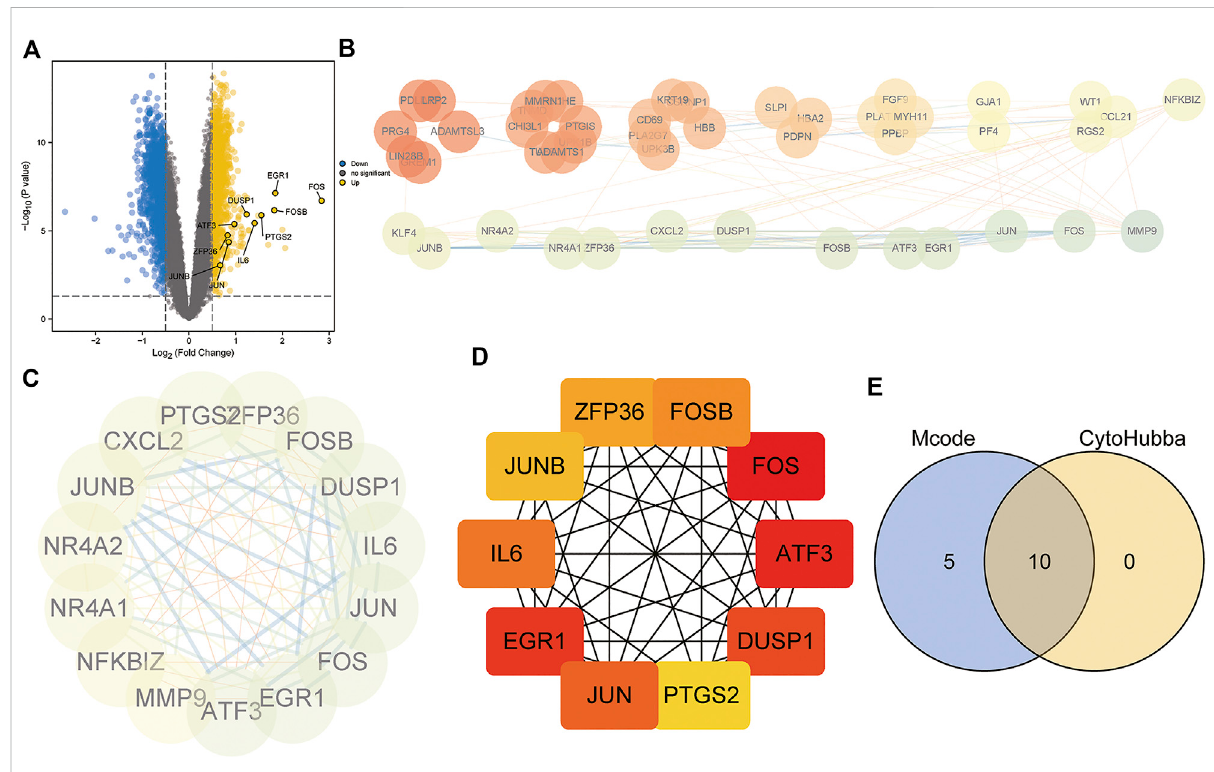
FIGURE 6 Protein – protein interaction (PPI) network construction and hub gene identi fi cation. (A) Volcano plot of DEGs between mitochondrial dysfunction-related clusters A and B. (B) PPI network based on STRING database. (C) Hub genes identi fi ed by Cytoscape MCODE plug-in. (D)